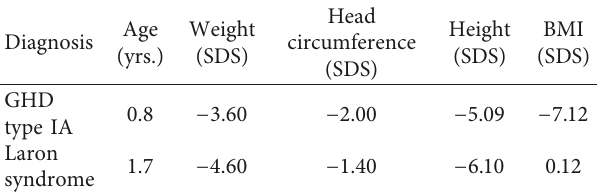
Figure 1: Comparison of facial features of the two patients: (a) the GHD type IA patient and (b) the Laron syndrome patient. Table 2: Auxological parameters of the two patients at the first endocrinological